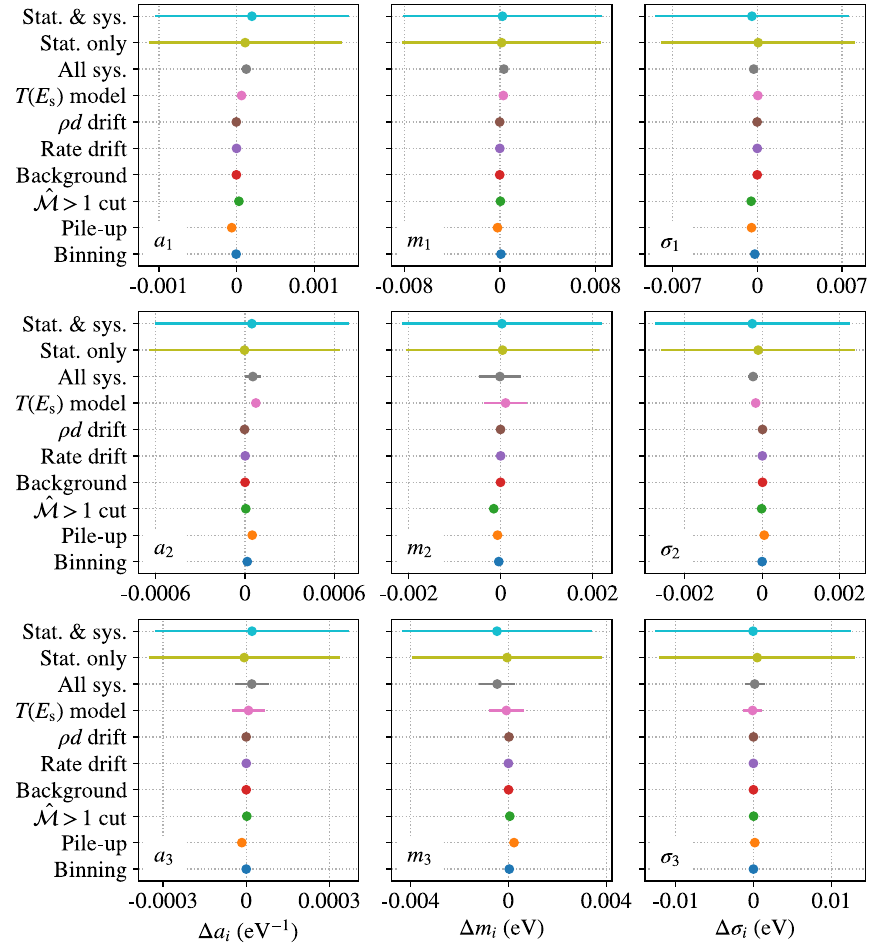
systematic uncertainties for all nine individual energy loss parameters as obtained from Monte Carlo simulations. Shown are the total uncertainty (stat. and sys.), the statistical uncertainty (stat. only) as well as the total systematic uncertainty (all sys.). The data points indicate the difference between the fit to data without any systematic effects and the median of the parameter distribution obtained from the fits to 10,000 MC samples with systematic effects. The bars indicate the standard deviation of the distributions. The measurement is strongly dominated by the statistical uncertainty. The investigated systematic effects do not significantly contribute to a broadening of the parameter uncertainties nor to a significant shift of their mean